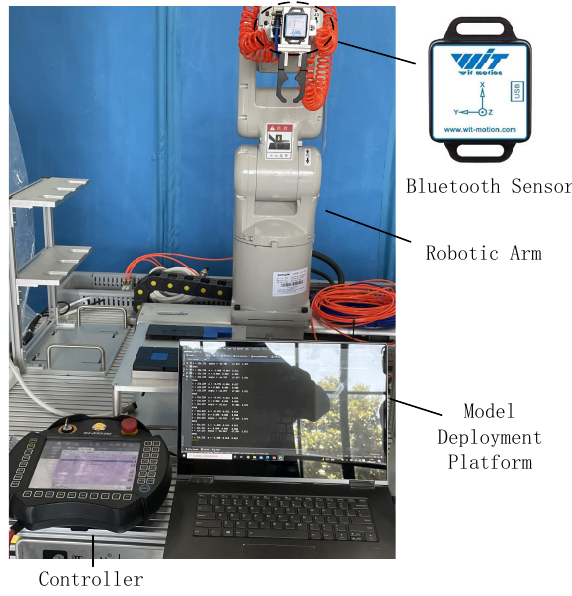
Figure 1. Experiment platform.